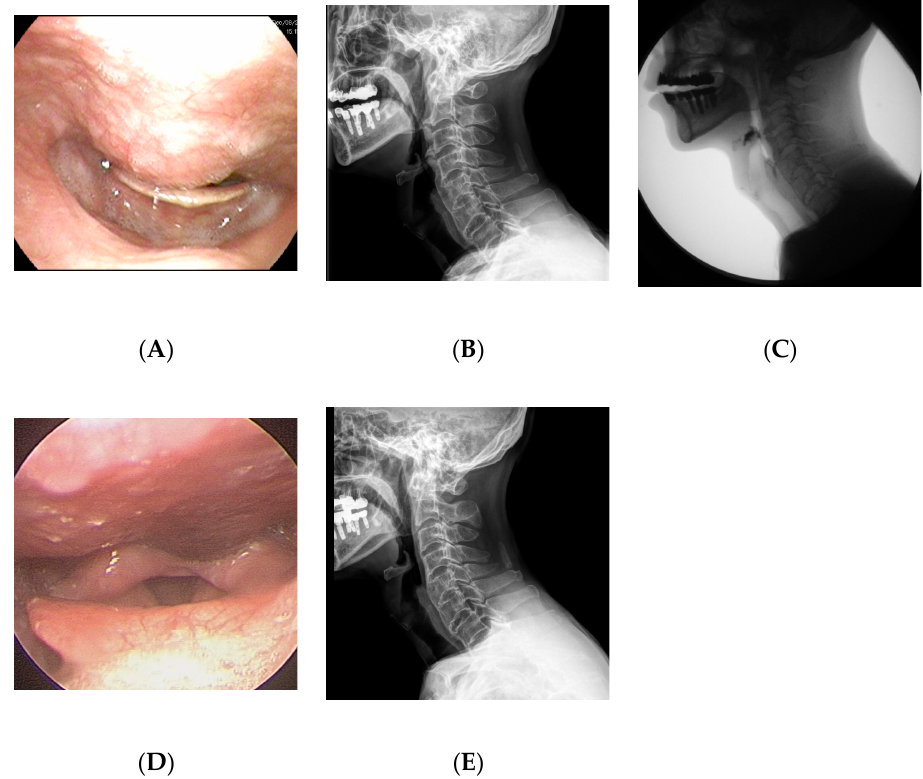
Figure 2. A 65-year-old man presented with dysphagia and odynophagia for the past 3 months and 12 kg weight loss. ( A ) Preoperative laryngoscopy revealed a protruding mass at the posterior pharyngeal wall obstructing the laryngeal entrance. ( B ) Lateral cervical radiograph showed a bridging osteophyte at the anterior cervical and thoracic vertebral bodies, suggesting DISH. ( C ) Preoperative visual fluoroscopic swallowing study revealed moderate dysphagia in the oral and pharyngeal phases with incomplete closure of the epiglottis. ( D ) Postoperative laryngoscopy showed disappearance of the protruding mass at the posterior pharyngeal wall. ( E ) There was no evidence of regrowth of the osteophyte at 1-year postoperative radiograph.